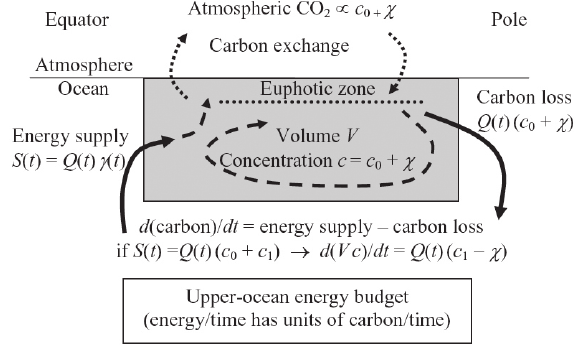
Fig . 5. – schematics of the upper-ocean dissolved inorganic carbon balance in our idealised